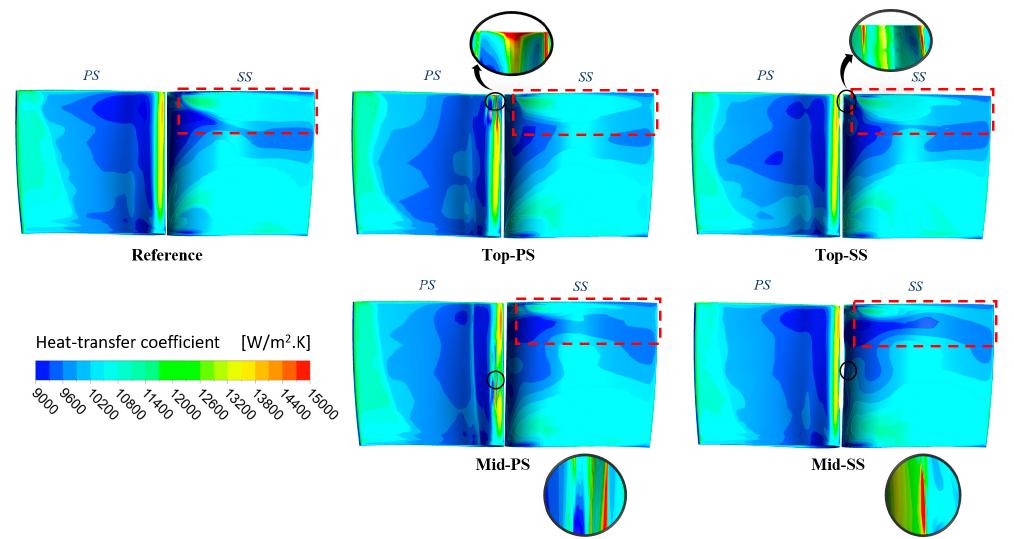
Figure 13. Heat-transfer coefficient distribution on the R1 surface under different damaged-blade conditions.